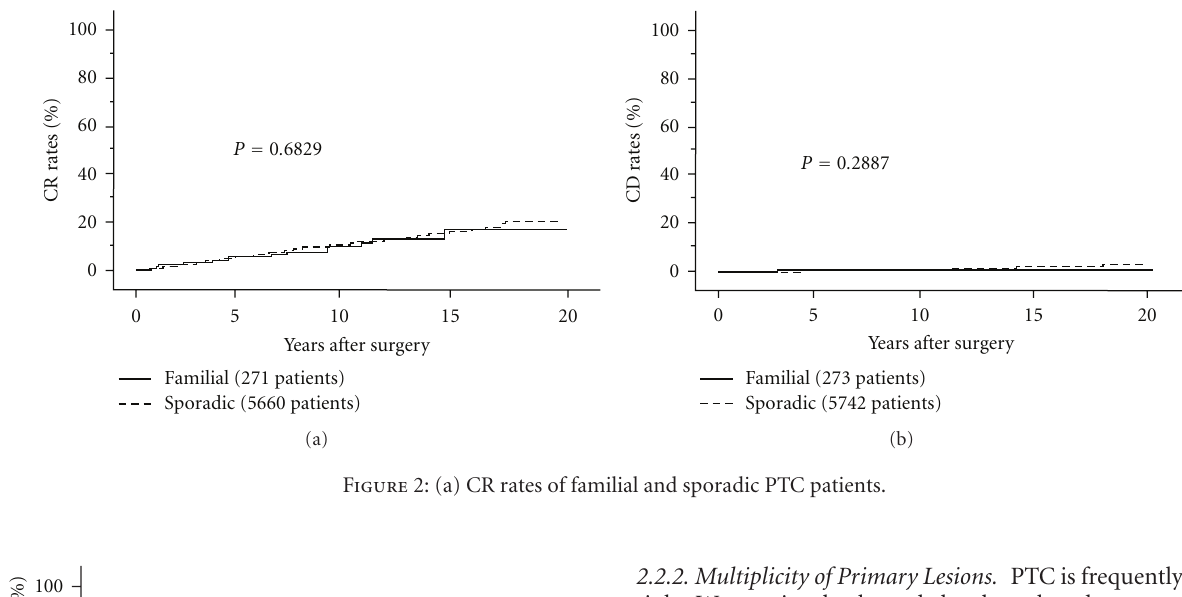
Figure 2: (a) CR rates of familial and sporadic PTC patients.